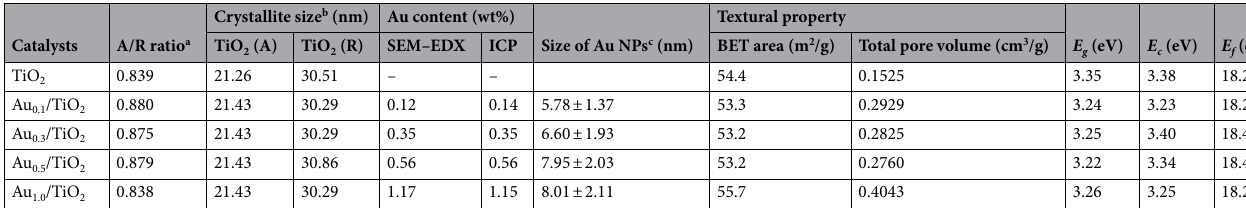
Table 1. Morphology and optical property of all synthesized Au x /TiO 2 and the parental TiO 2 NPs. a Estimated from XRD analysis using Spurr and Myers equatio b Estimated from XRD analysis using Debye–Scherrer equation. c Estimated from HRTEM analysis.